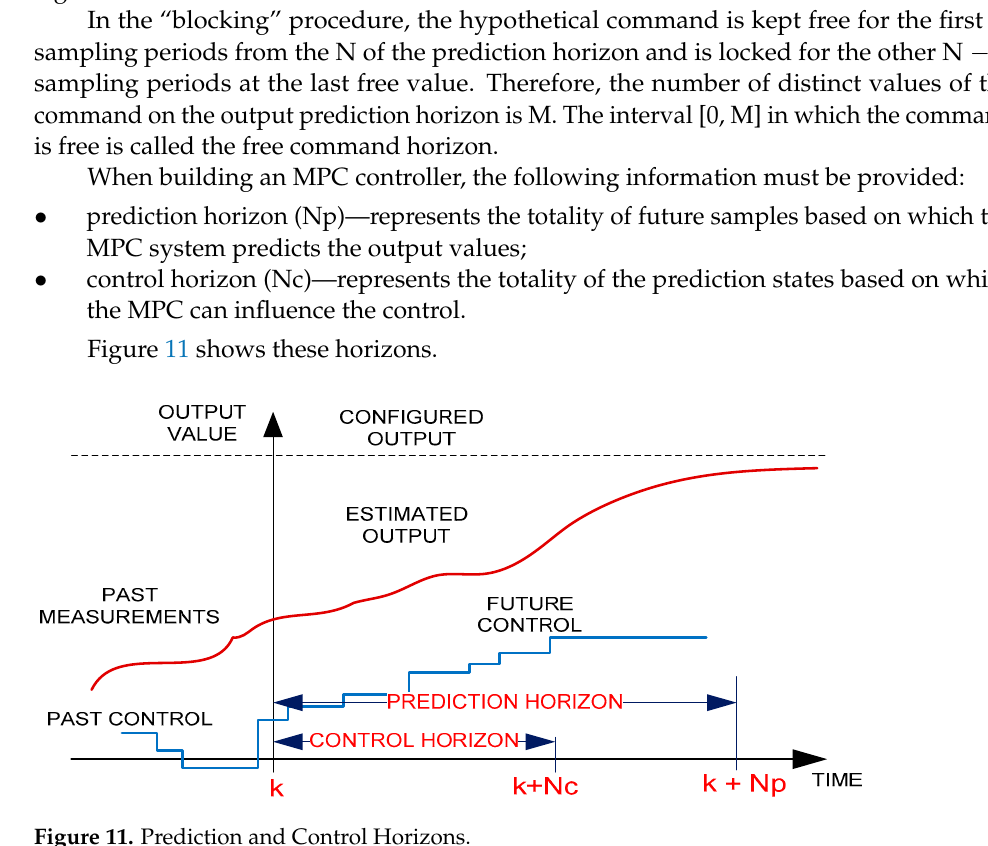
Figure 12. Moving the prediction horizon forward in time. When adjusting the proportional physical processes, a value approximately equal to the duration of the index response of the process is recommended for the output predic- tion horizon. By choosing a significantly lower value of the prediction horizon, the control system becomes damped oscillator or ascending (unstable) oscillator. Occasionally, to avoid the effect of large and sudden variations (step type) of the ref- erence, a delay filter, of the first order, is used. Next, we will consider the sampling period T = 1, when the length of the prediction horizon is equal to N. Determining the optimal control on the output prediction horizon is performed by minimizing a square shape criterion (cost function) J ( k ):